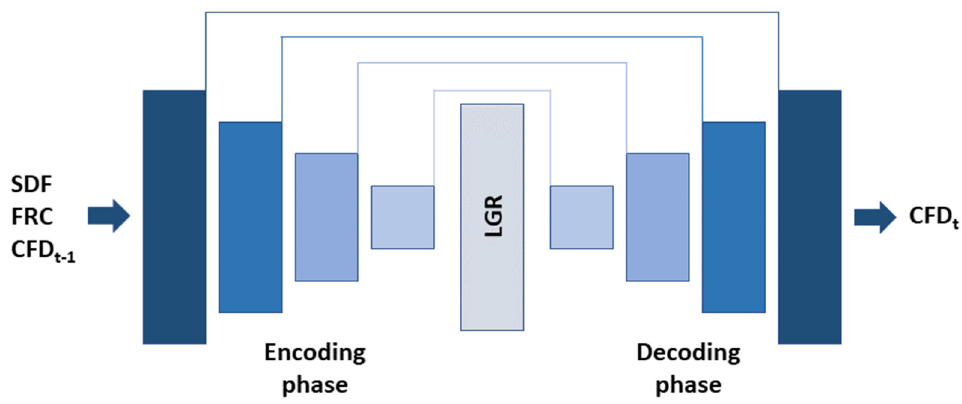
Figure 3. U-Net with 3 decoders.